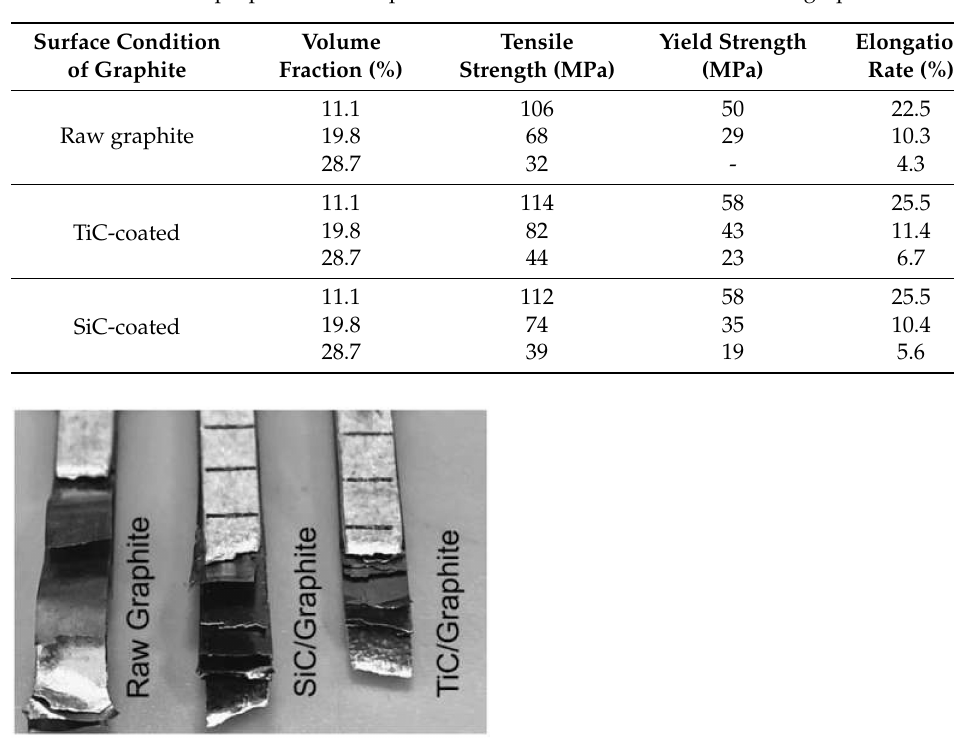
Figure 11. Comparison of interfacial thermal conductance to different composites. Table 3. Mechanical properties of composites with different volume fractions of graphite.